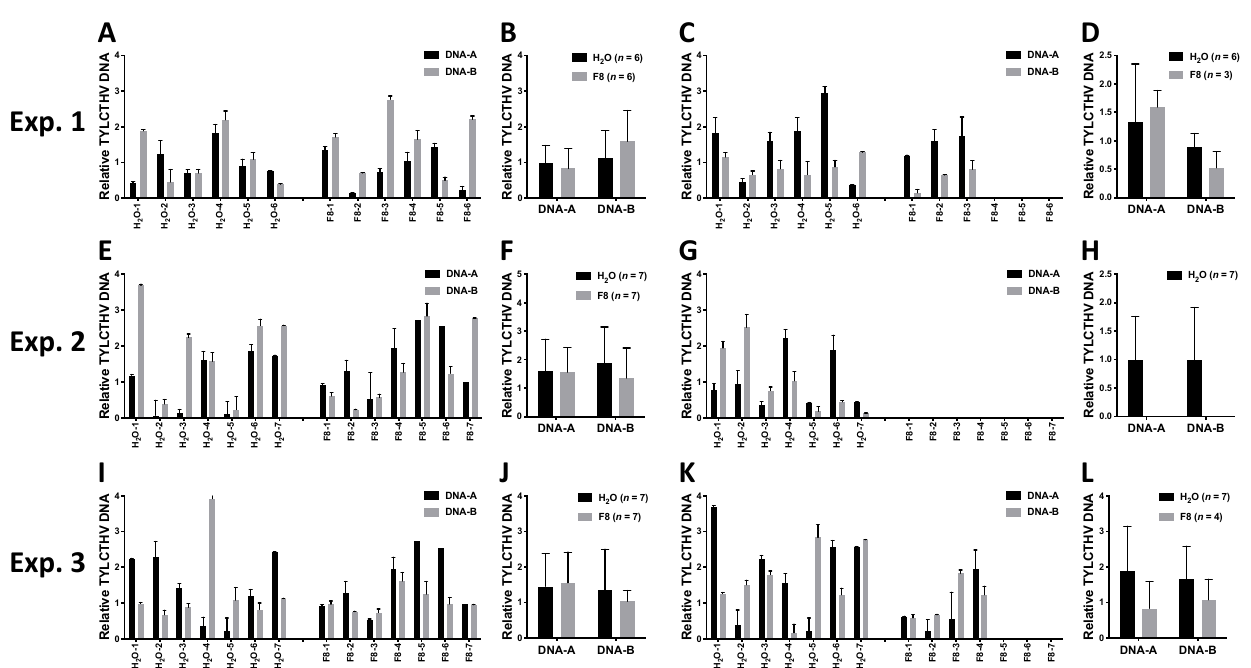
Figure 2. Quantification of TYLCTHV genomic DNA in inoculated tomato plants pretreated with F8-culture filtrate or H 2 O. Relative TYLCTHV DNA level was quantified from H 2 O or F8-culture filtrate pretreated plants corresponding to Exp. 1, 2, and 3 in Figure 1 by qPCR analysis. TYLCTHV DNA was detected from individual samples of TYLCTHV-inoculated leaves ( A , E , I ) or systemic leaves ( C , G , K ). Three technical replicates were performed for all samples. Data represent mean ± SEM. β -actin was used as an input control. The average of TYLCTHV DNA detected from ( A , E , J ) are shown in ( B , F , J ), respectively. The average of TYLCTHV DNA detected from ( C , G , K ) are shown in ( D , H , L ), respectively. Data represent mean ± SEM; n = 3–6 biological replicates. β -actin was used as an input control. Student’s t -test was used for comparative analysis of the data for the F8-culture filtrate pretreated group and the H 2 O pretreated control group.